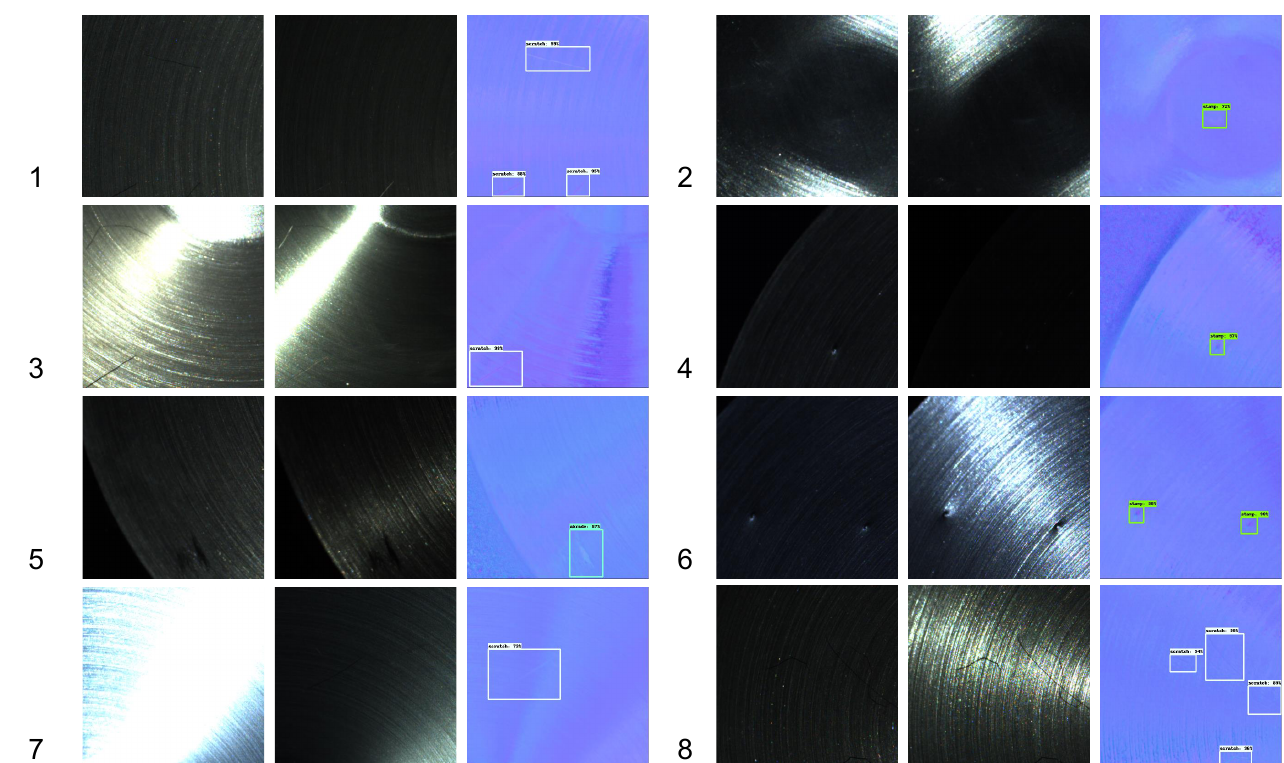
Figure 10. Diagram of detection results. We show the results of 8 sample. The numbers in the images represent the serial numbers of the samples. For each sample, we display 2 input images with the detection result.